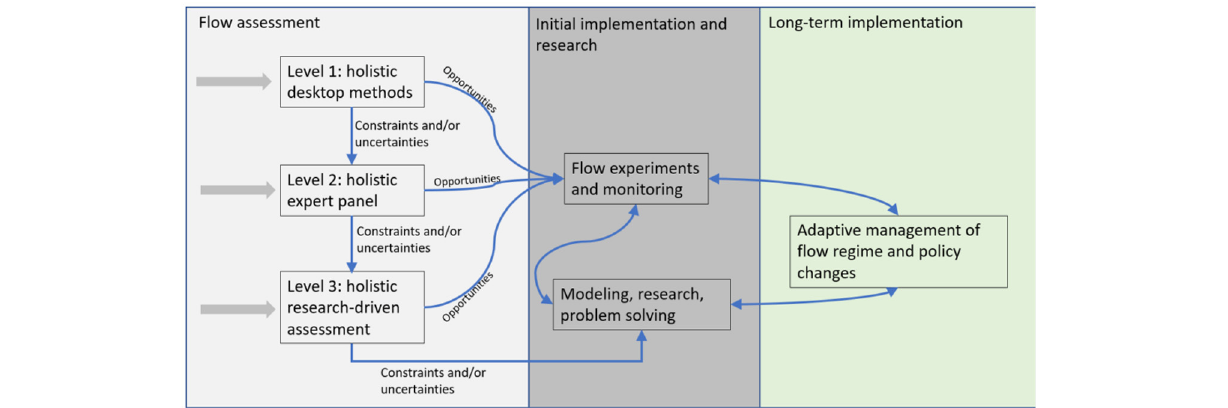
FIGURE 1 | Three-level framework for environmental flow assessment and implementation. Levels are selected based on the specific geograhpic context (e.g., spatial scope, type of resources at stake), the availability of data and funding, and the level of confidence required of the flow recommendations. The levels can stand alone (thick gray arrows indicate alternative entry points) or levels can be sequential (vertical sequence from Level 1 to 3). All levels have the potential to produce flow recommendations that can be implemented through collaboration with water managers (arrow marked “opportunities” leading to “flow